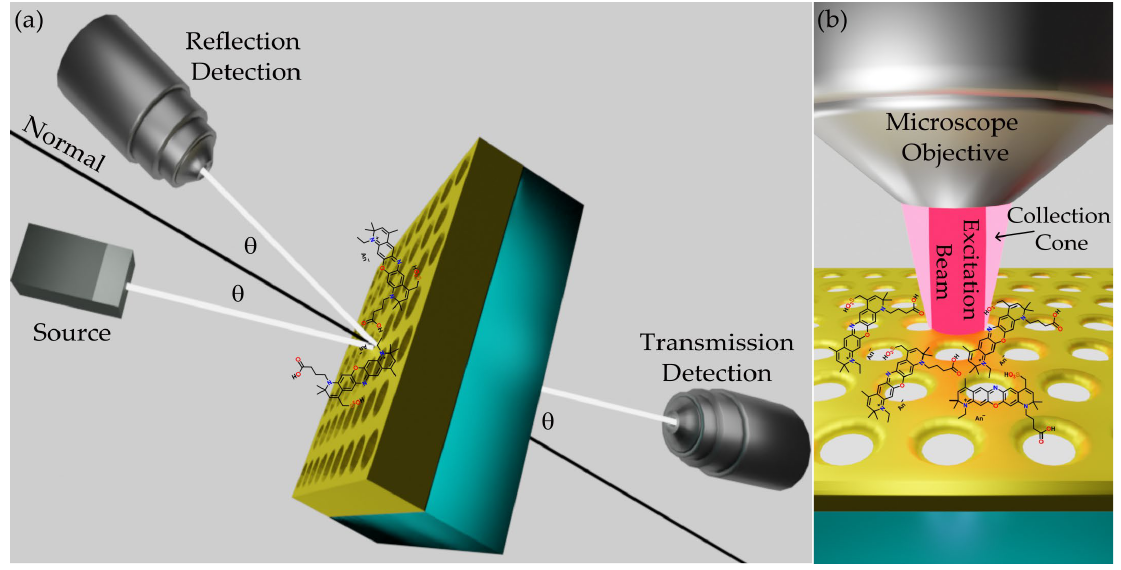
Figure 2. Measurement schemes. ( a ) Reflectance and transmittance outline. The R spectra were recorded in specular reflectance configuration, while the T spectra were collected by rotating the source and the detector by the same angle with respect to the normal incidence of the plasmonic metasurface. ( b ) Excitation and collection epifluorescence scheme for photoluminescence detection.